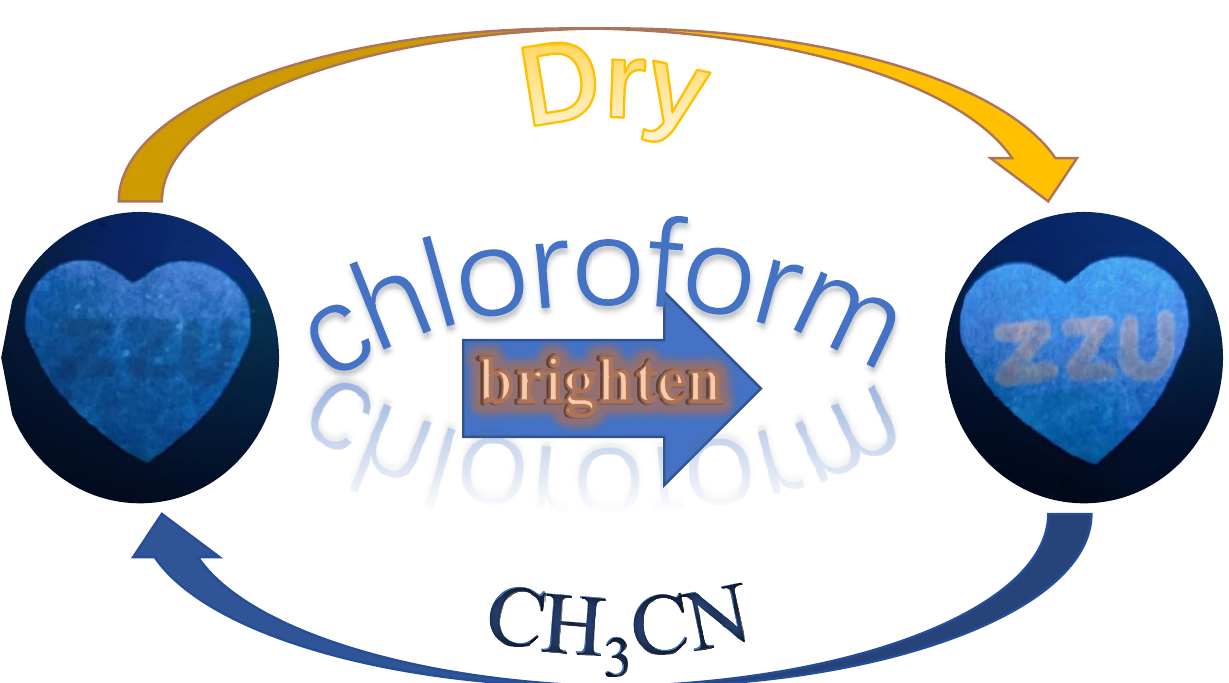
Figure 7. Vapor-responsive information recognition of Cage-1 .